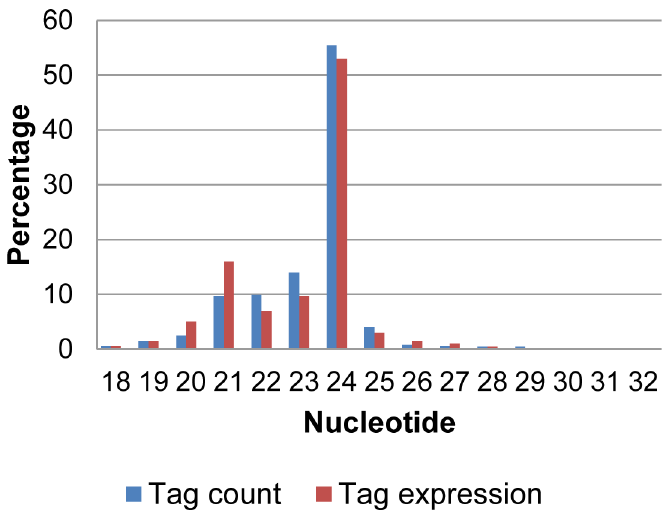
Fig 1. Length distribution of unique small RNA reads. All six generatedsmall RNA librariesdisplayedtwo peaks at 21 and 24 nt.